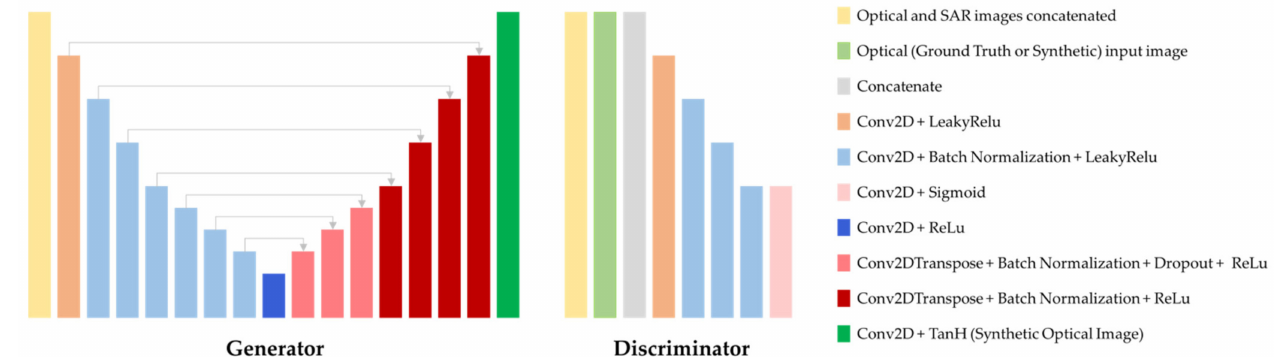
Figure 4. Pix2pix cGAN architecture (Generator and Discriminator).